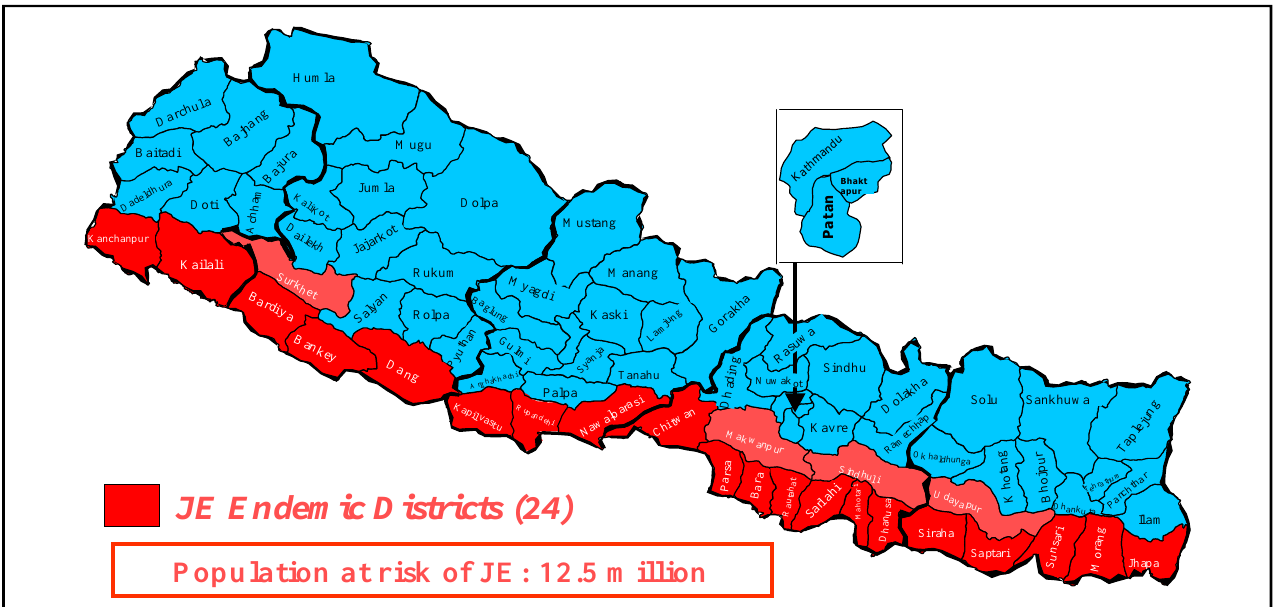
Fig. 1 : Japanese Encephalitis Endemic